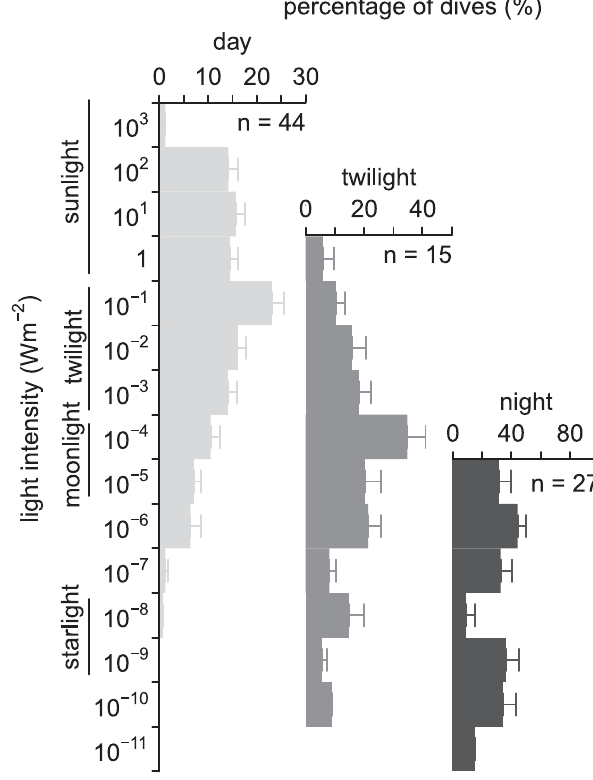
Figure 2. Histograms of light utilization during diving sepa- rated by period. Mean 6 se values across all individuals (n indicated). Daytime values are based on both in-situ and modeled light intensity whereas the twilight histogram is based solely on in-situ values and the night histogram was generated from modeled values (see methods). Lines left of plot give equivalent range of ambient light levels from the sun, moon and stars.